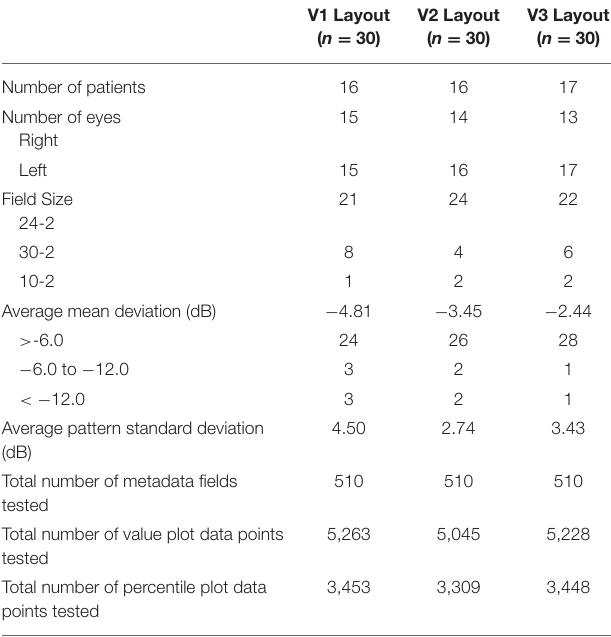
TABLE 1 | Characteristics of validation set visual field